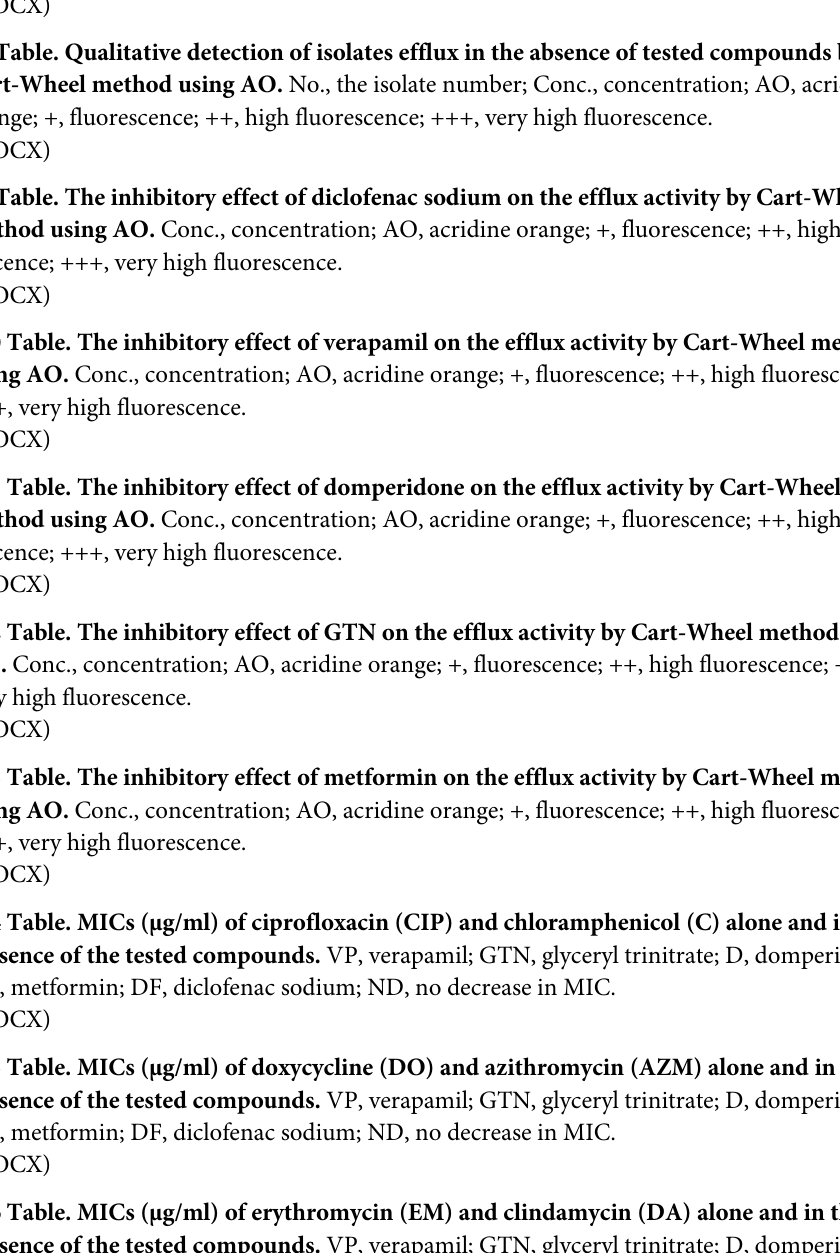
S6 Table. Results of EtBr-Cartwheel method and the prevalence of efflux genes in the selected isolates (n = 72). No., the isolate number; P, positive efflux isolate; N, negative efflux isolate; I, intermediate efflux isolate; W, isolated from wound; U, isolated from urine; B, iso- lated from burn; E, isolated from endotracheal aspirate; S, isolated from sputum; +, gene pres- ent; -, gene absent. S7 Table. The profile of the selected isolates (n = 26) for further analysis of efflux and test- ing the activity of tested drugs. No., isolate number; (+), positive for the gene; (-), negative for the gene; EtBrCW, EtBr Cart-Wheel test. S8 Table. Qualitative detection of isolates efflux in the absence of tested compounds by Cart-Wheel method using AO. No., the isolate number; Conc., concentration; AO, acridine orange; +, fluorescence; ++, high fluorescence; +++, very high fluorescence. (DOCX) S9 Table. The inhibitory effect of diclofenac sodium on the efflux activity by Cart-Wheel method using AO. Conc., concentration; AO, acridine orange; +, fluorescence; ++, high fluo- rescence; +++, very high fluorescence. S10 Table. The inhibitory effect of verapamil on the efflux activity by Cart-Wheel method using AO. Conc., concentration; AO, acridine orange; +, fluorescence; ++, high fluorescence; +++, very high fluorescence. S11 Table. The inhibitory effect of domperidone on the efflux activity by Cart-Wheel method using AO. Conc., concentration; AO, acridine orange; +, fluorescence; ++, high fluo- rescence; +++, very high fluorescence. S12 Table. The inhibitory effect of GTN on the efflux activity by Cart-Wheel method using AO. Conc., concentration; AO, acridine orange; +, fluorescence; ++, high fluorescence; +++, very high fluorescence. S13 Table. The inhibitory effect of metformin on the efflux activity by Cart-Wheel method using AO. Conc., concentration; AO, acridine orange; +, fluorescence; ++, high fluorescence; +++, very high fluorescence. S14 Table. MICs ( μ g/ml) of ciprofloxacin (CIP) and chloramphenicol (C) alone and in the presence of the tested compounds. VP, verapamil; GTN, glyceryl trinitrate; D, domperidone; MF, metformin; DF, diclofenac sodium; ND, no decrease in MIC. S15 Table. MICs ( μ g/ml) of doxycycline (DO) and azithromycin (AZM) alone and in the presence of the tested compounds. VP, verapamil; GTN, glyceryl trinitrate; D, domperidone; MF, metformin; DF, diclofenac sodium; ND, no decrease in MIC. S16 Table. MICs ( μ g/ml) of erythromycin (EM) and clindamycin (DA) alone and in the presence of the tested compounds. VP, verapamil; GTN, glyceryl trinitrate; D,